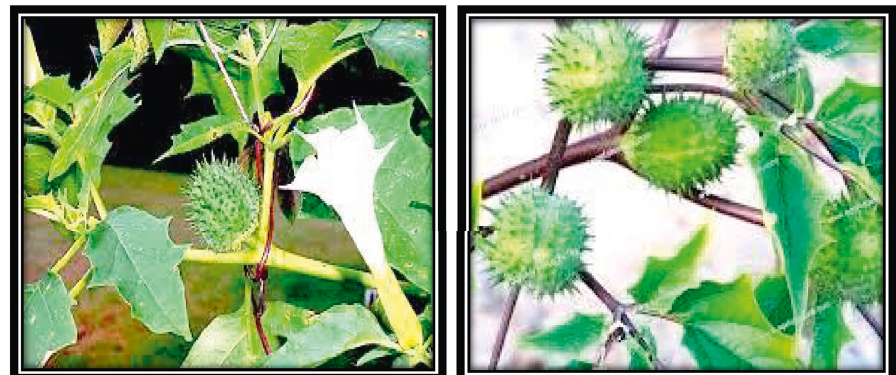
Figure 1: Datura stramonium flowers, leaves, and fruit are taken from East Wollega Zone, Gudaya Bila District, Darbes Kebele, Oromia, Ethiopia.